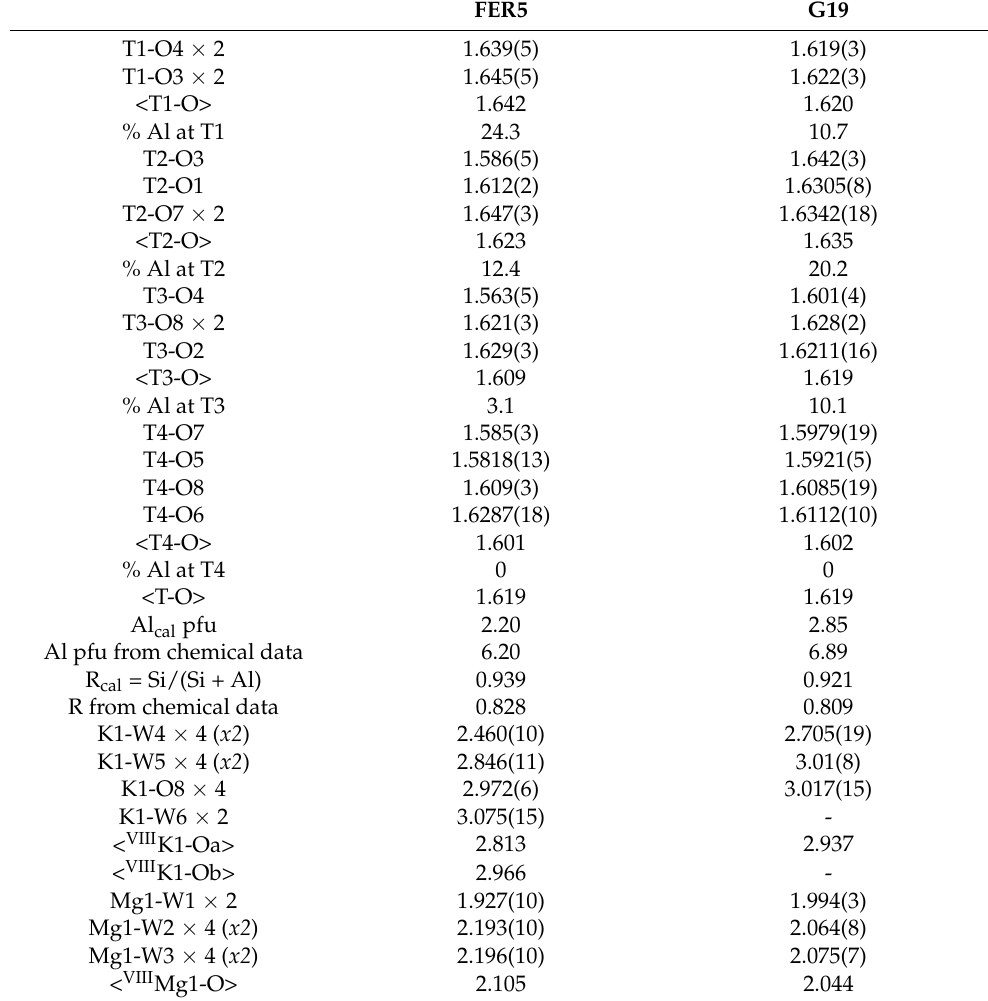
Table 6. Relevant bond distances (Å). The Al population at the various tetrahedral sites T (% Al) and the corresponding R = Si/(Si + Al) were calculated using the equation of Jones [72]. Data of ferrierite (G19) from Giacobbe et al. [22] are reported for comparison. Due to short, mutually excluding W–W contacts, two different coordination for the Mg(H 2 O) 62+ complex are expected. Similarly, two different configurations for the eight-fold coordinated K1 site are expected, both being bonded to 4 × O8, the first one linked to 2 × W5 and 2 × W4, (a) and the second one to 2 × W5 and 2 × W6